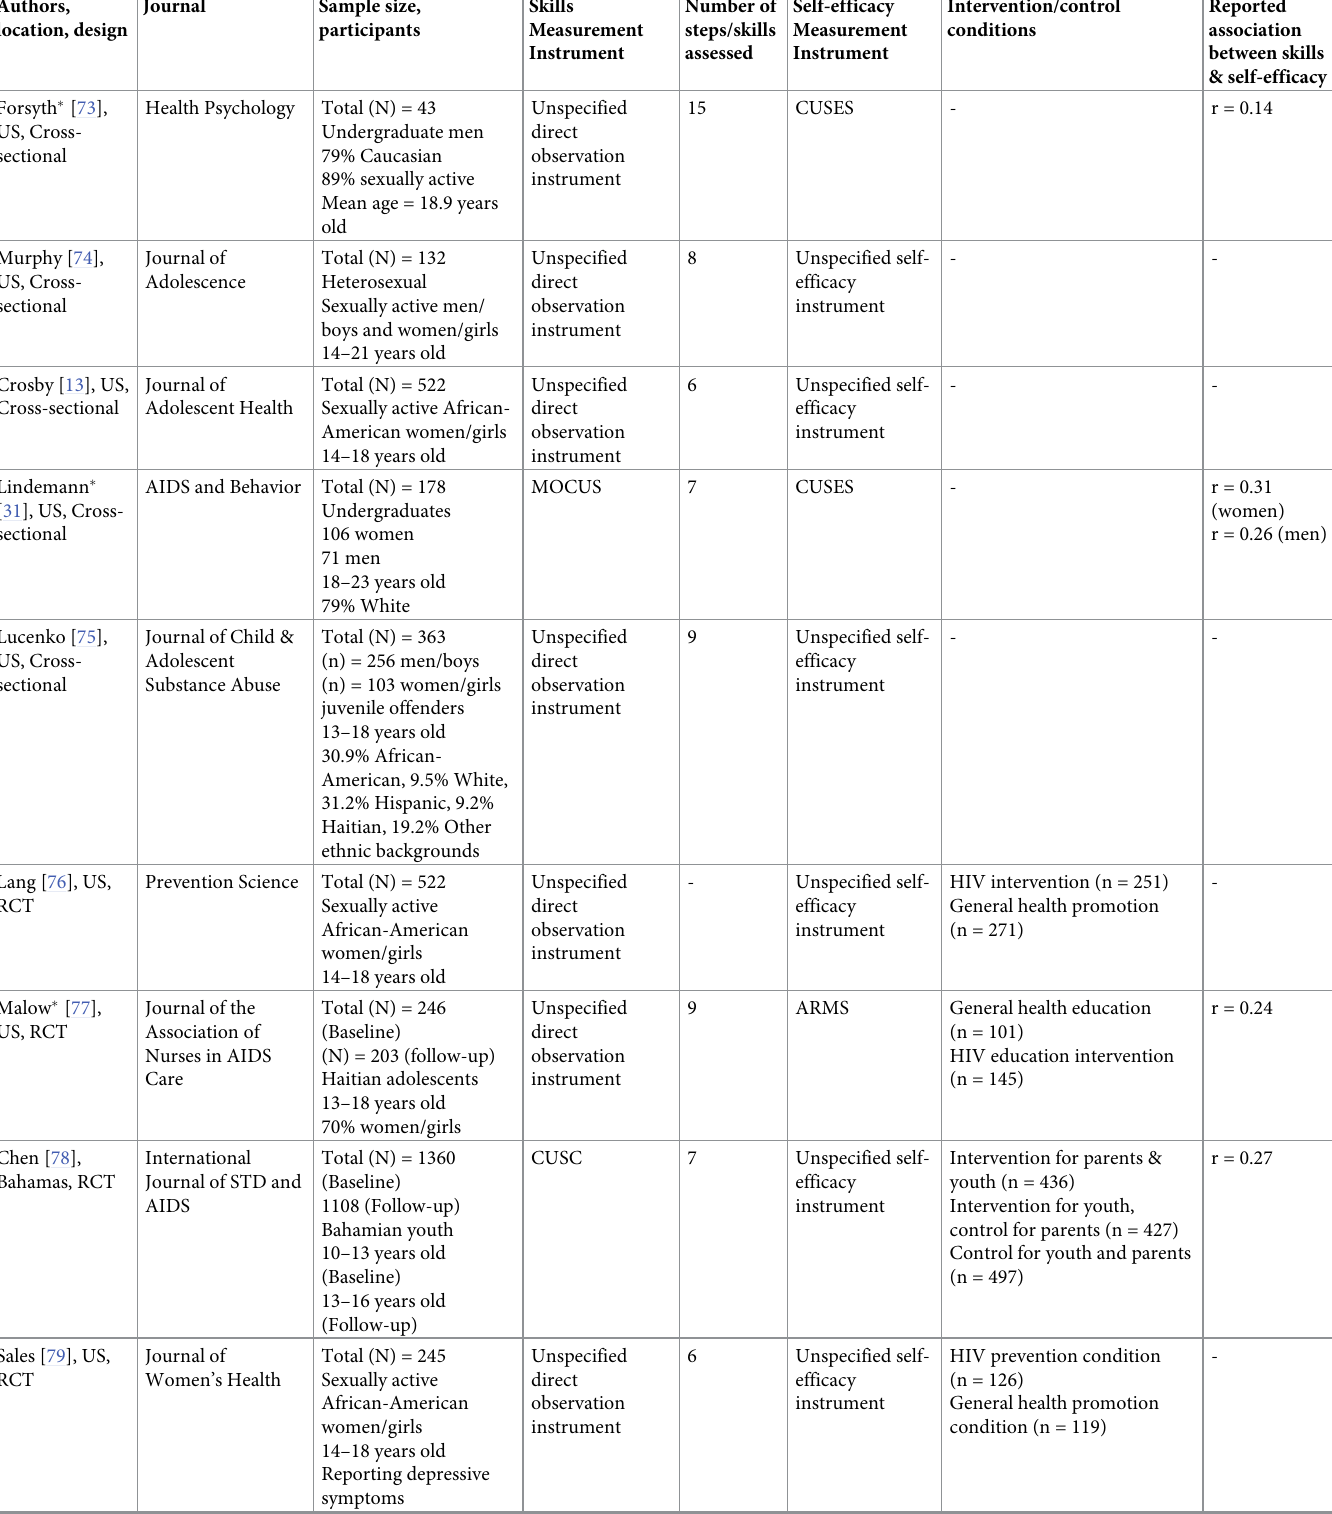
Table 2. Detailed summary of included